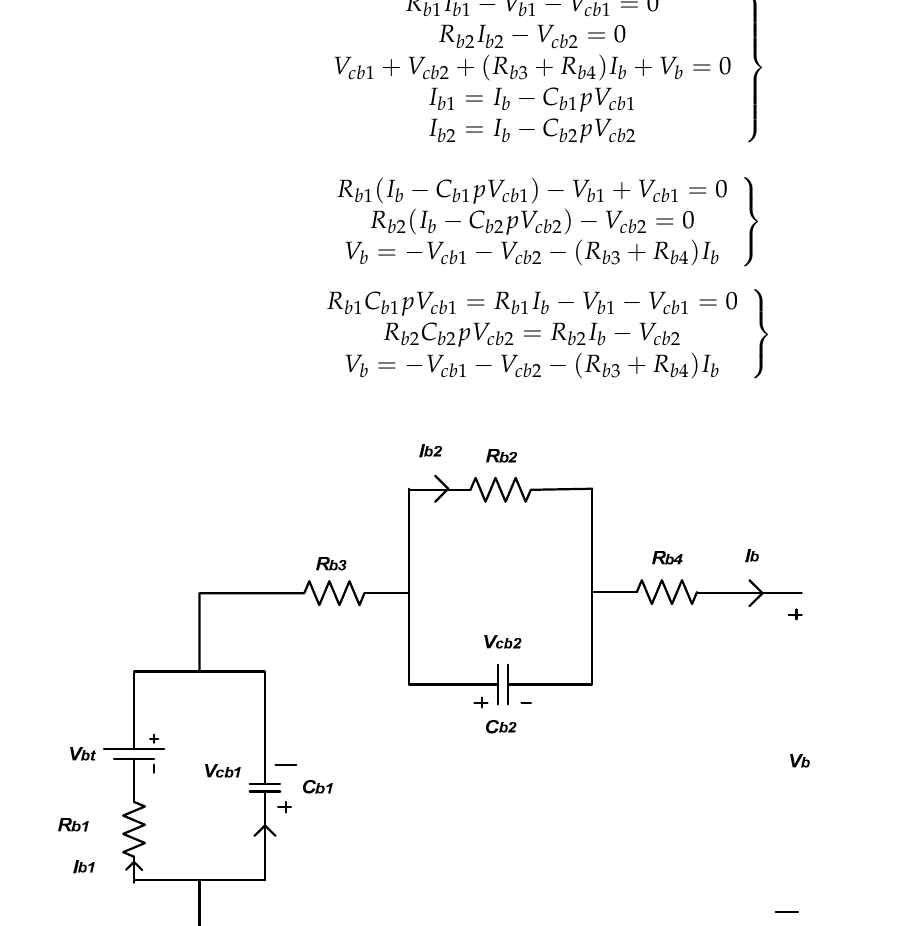
Figure 5. Battery equivalent circuit